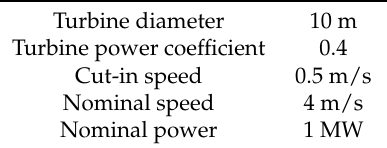
Figure 9. 10m-diameter turbine power production. Table 2. Characteristics of the 10m-diameter tidal